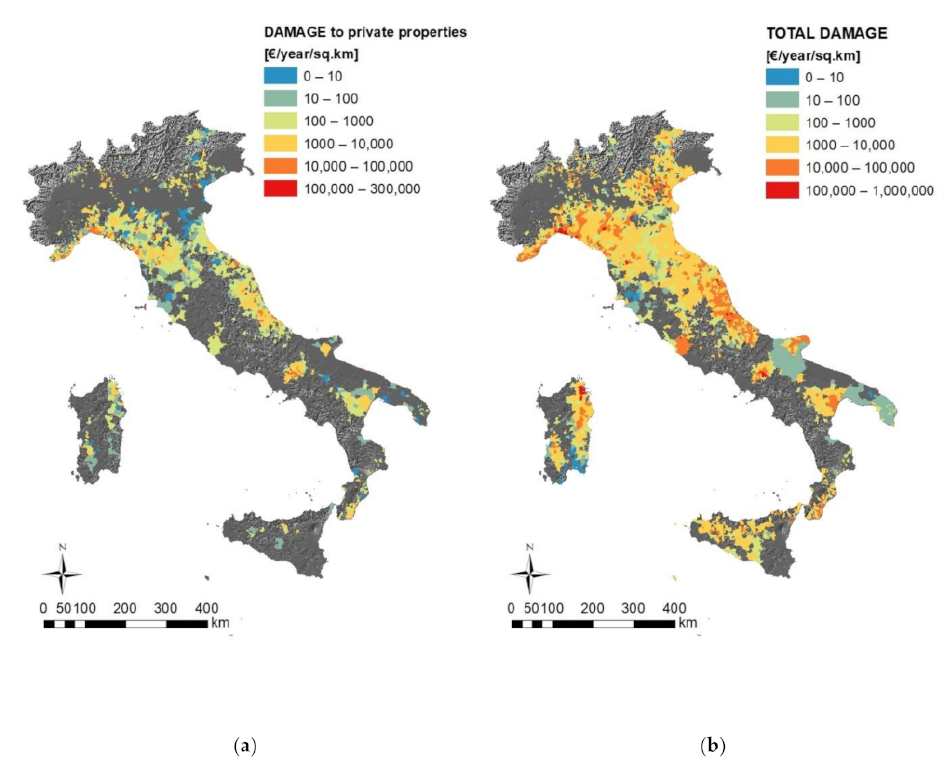
Figure 4. Overview of flood damage occurring between 2013 and 2020, normalized to the municipal surface and to the period of 7 years: ( a ) map of damages to private properties; ( b ) map of total damage, as the sum of damages to public services, private properties, and commercial